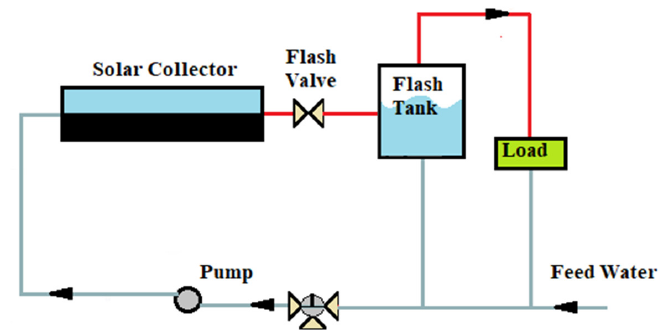
Figure 7. Indirect steam generation system with flash boiler without backup. Adapted from Ref. [44], Copyright (1985), with permission from Elsevier. Copyright (1985), with permission from